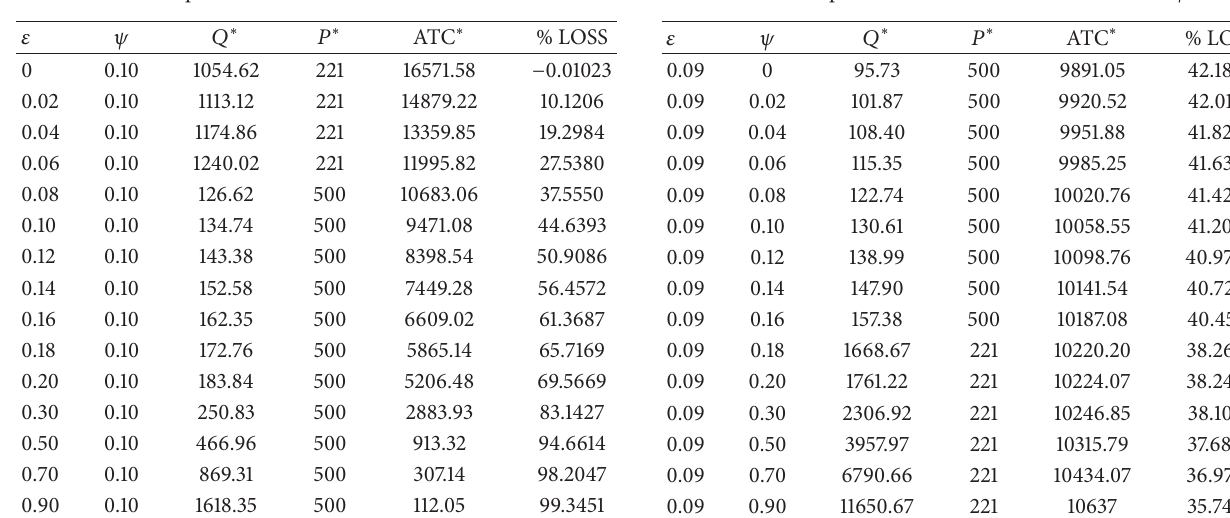
Table 1: Optimal solutions for different values of 𝜀 . Table 2: Optimal solutions for different values of 𝜓 .